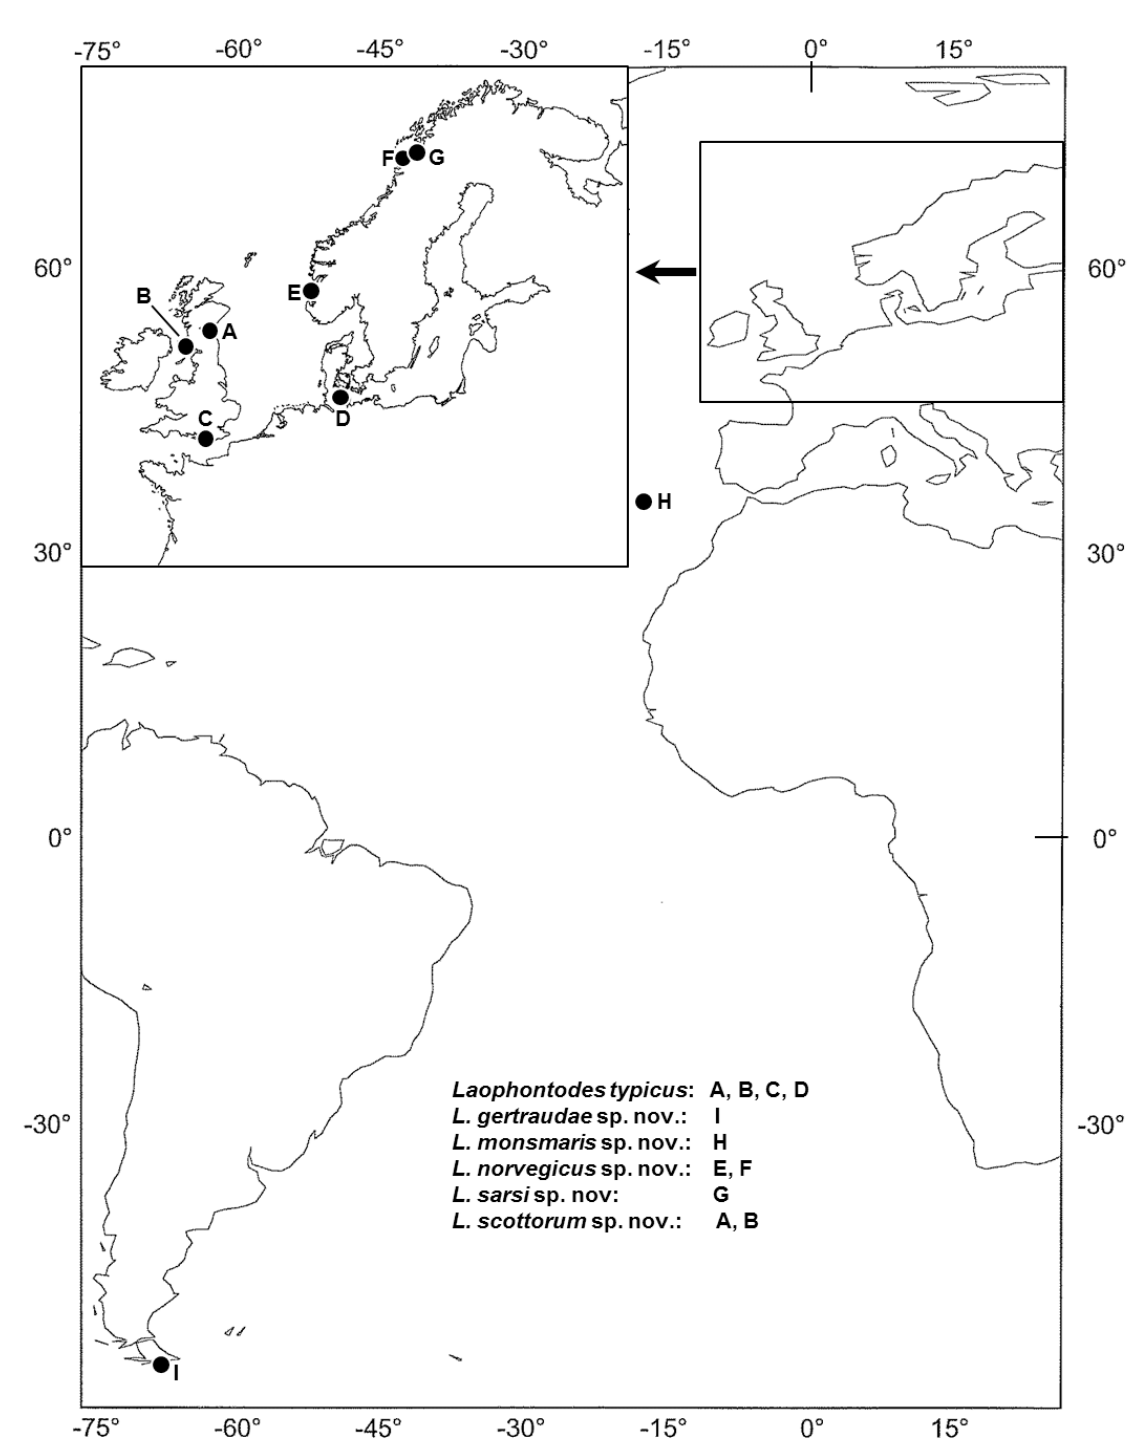
Fig. 1. Map of reported localities for species treated in the present contribution. A = Firth of Forth, Scotland (UK); B = Firth of Clyde, Scotland (UK); C = coast of Sussex (UK); D = Bight of Kiel (Germany); E = Bukken (Norway); F = Salten fjord (Norway); G = Skjerstad fjord (Norway); H = Great Meteor Seamount; I = Isla Nueva,